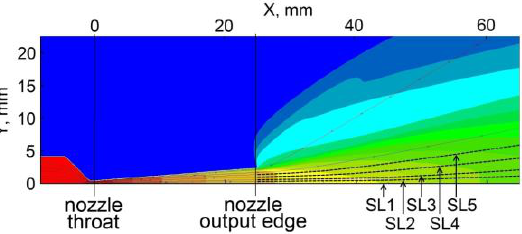
Fig. 1. Distribution of Ar atom density inside and outside of the conical nozzle (Y = 0 corresponds to the axis of sym- metry of the nozzle, SL1-SL5 represent five stream lines). The magnitude of the density is represented by a color scale: ~5 kg/m 3 (red), ~0.3 kg/m 3 (yellow), ~10 -2 kg/m 3